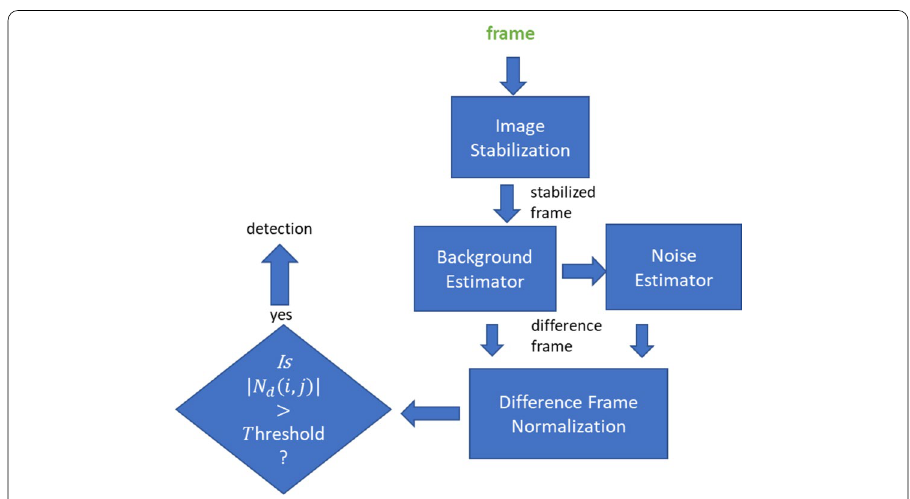
Fig. 7 Baseline detection